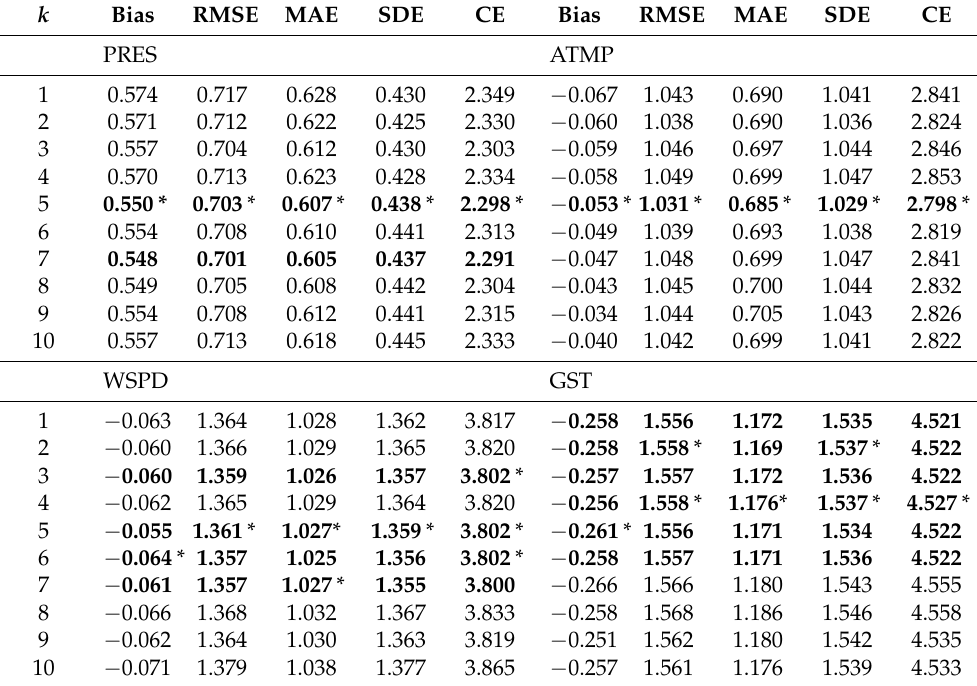
Table 4. Prediction errors as a function of the half time-window size ( k ).